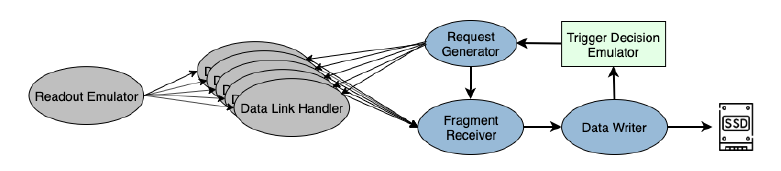
Figure 3. Schematic representation of the main elements that constitute the MiniDAQ test application.